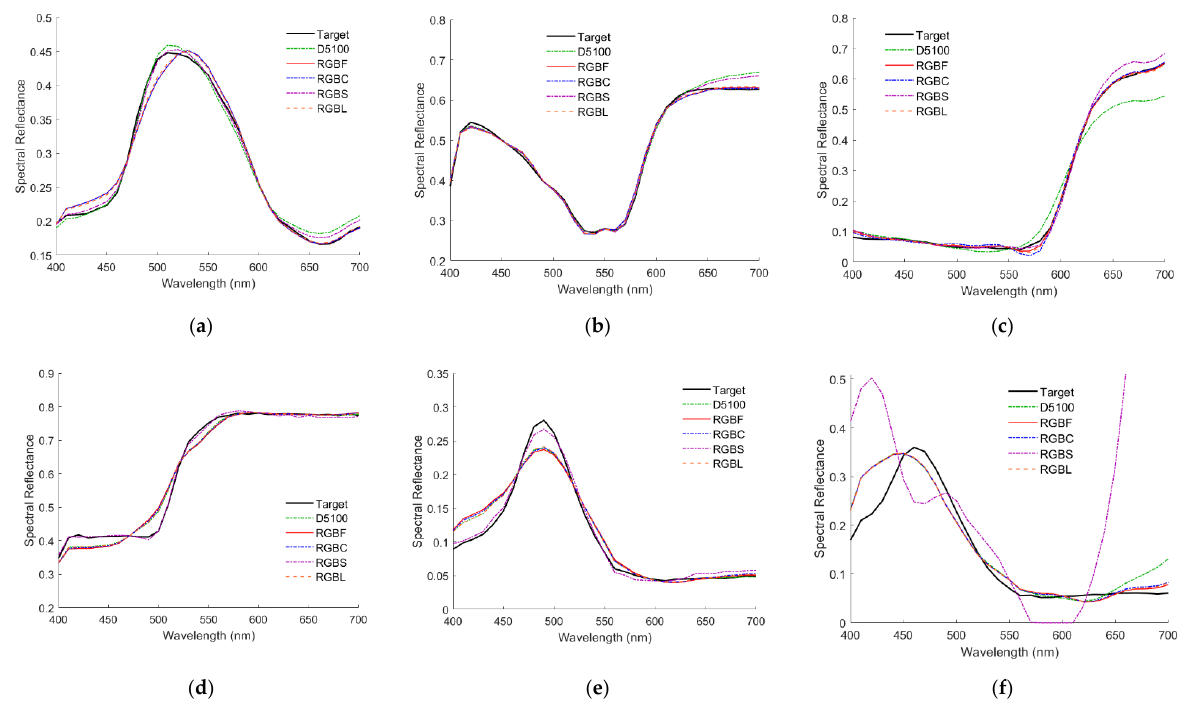
Figure 10. ( a – f ) are the same as Figure 9a–f respectively, except that spectra were reconstructed using the wPCA